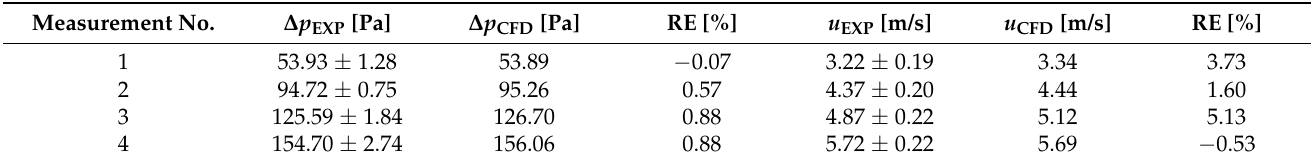
Table 3. Comparison of numerical and experimental results.